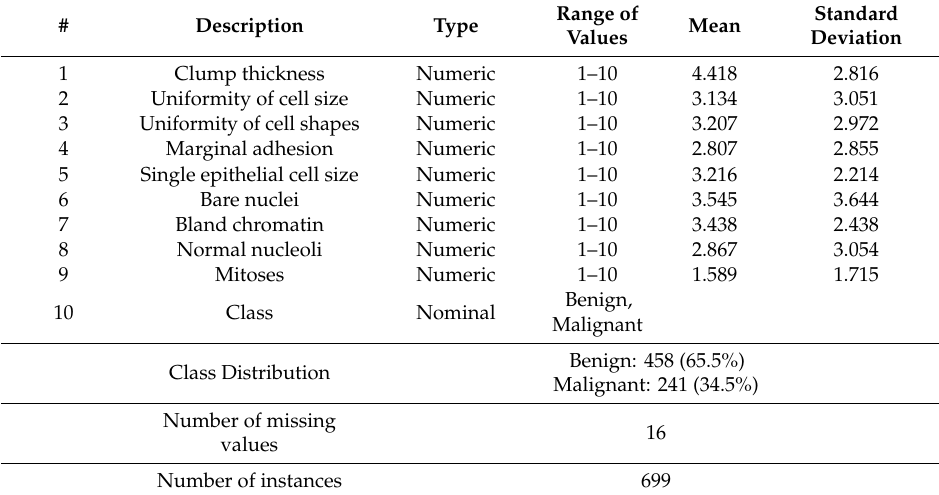
Table 1. Details of the attributes of the Wisconsin